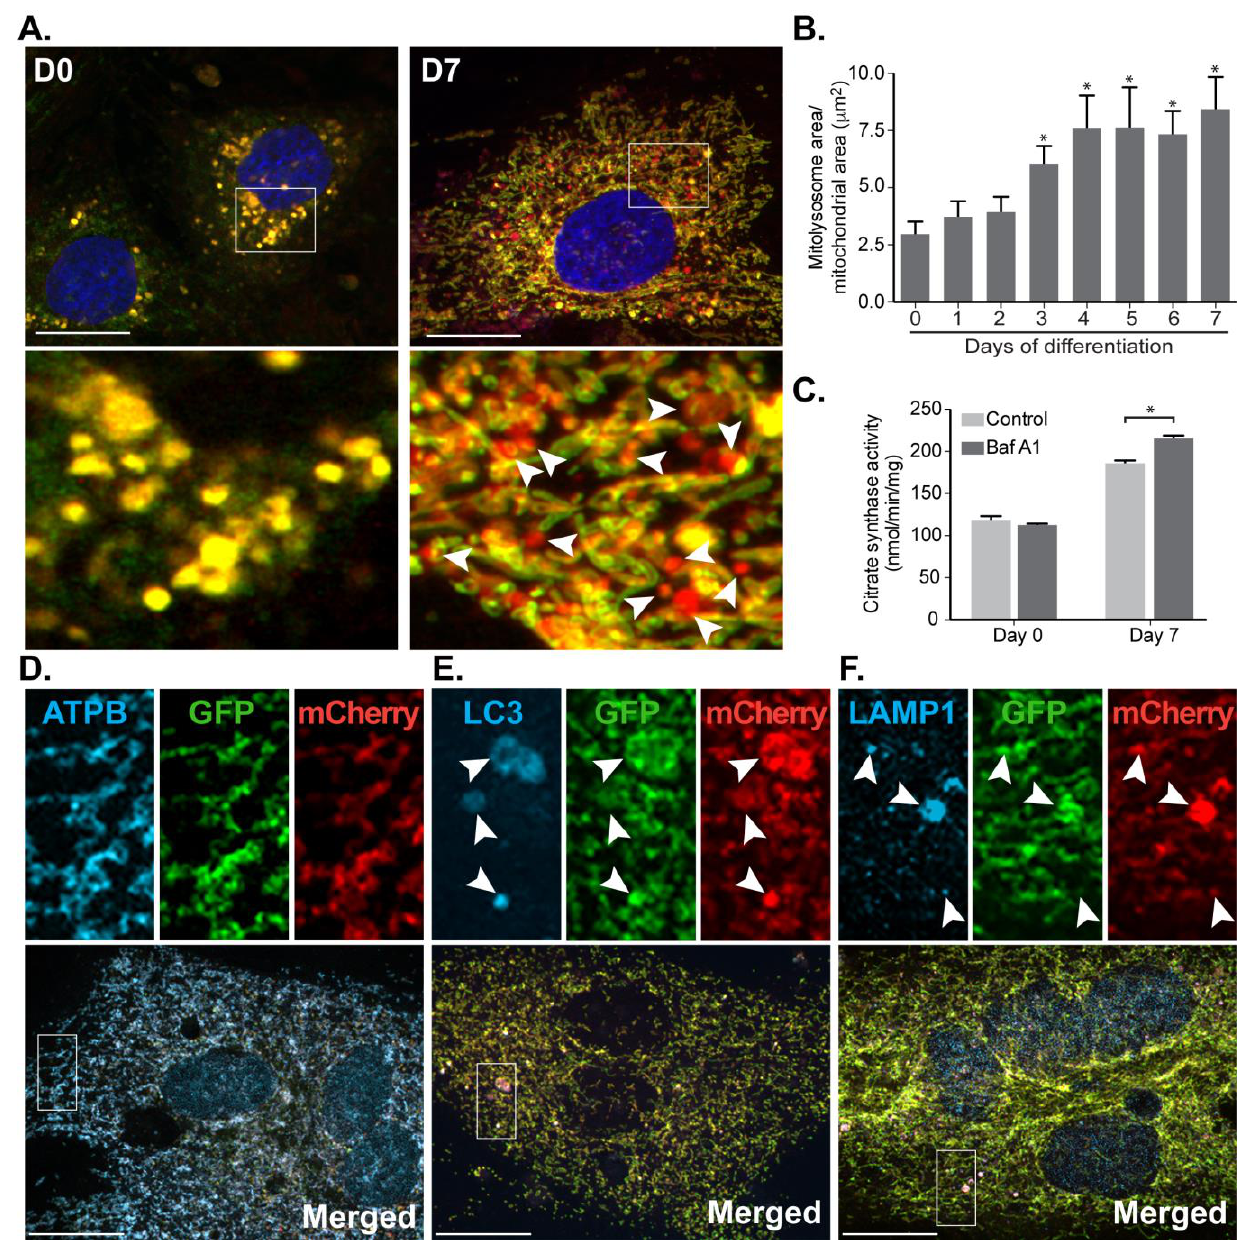
FIGURE 4: Mitophagy increases progressively during cardiomyocyte differentiation. (A) Representative images from mito -QC reporter H9c2 cells during differentiation. (B) Quantitation of total mitolysosome area per mitochondrial content was analysed during cardiomyocyte dif- ferentiation. (C) H9c2 cells were cultured in differentiation medium for 7 days and 50 nM Baf A1 was added into medium for the last 16 h prior to lysis. Immunostaining of beta subunit of ATP synthase (ATPB) (D) , LC3 (E) and LAMP1 (F) were performed in H9c2 cells differentiated for 7 days prior to fixation. Arrows indicate structures positive for both red- puncta and LC3 or LAMP1. Scale bar, 20 μm. All quantitative data are mean ± SEM from 3 independent experiments. * P <